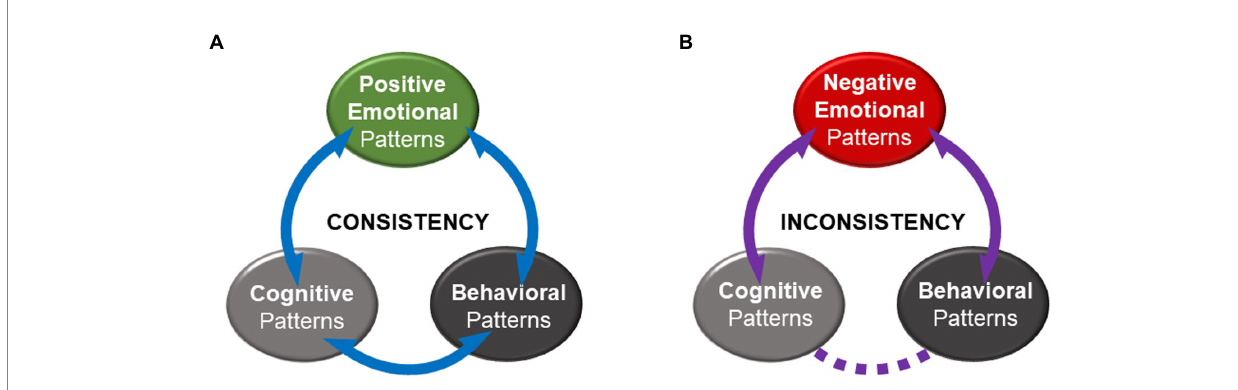
FIGURE 1 A model of Balance. (A) Positive emotional patterns indicate consistency, where meaning (i.e., ongoing bidirectional cognitive processes) connects behavior to cognition and emotion. (B) Negative emotional patterns indicate inconsistency, where there is interruption of meaning between cognition and behavior. Solid purple lines denote ongoing bidirectional cognitive processes that generate meaning. Dashed purple lines denote interruption in these